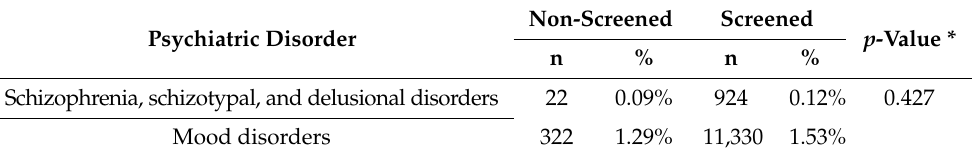
Figure 1. Selection of the study participants. Table 1. Prevalence of the psychiatric disorders among workers excluded from the study.